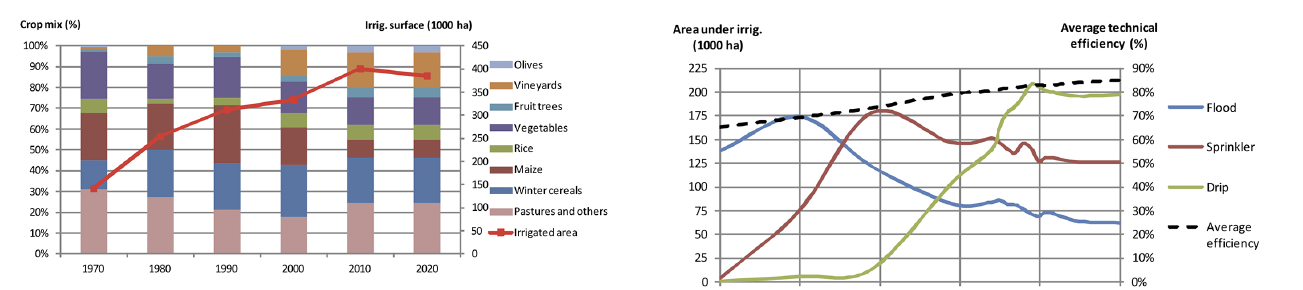
Fig. 5. Increase of irrigated area and change in crop mix in the Gua- diana Basin, 1970 to 2010. Source: based on statistical data from CHG (2013) and MAGRAMA (2013).